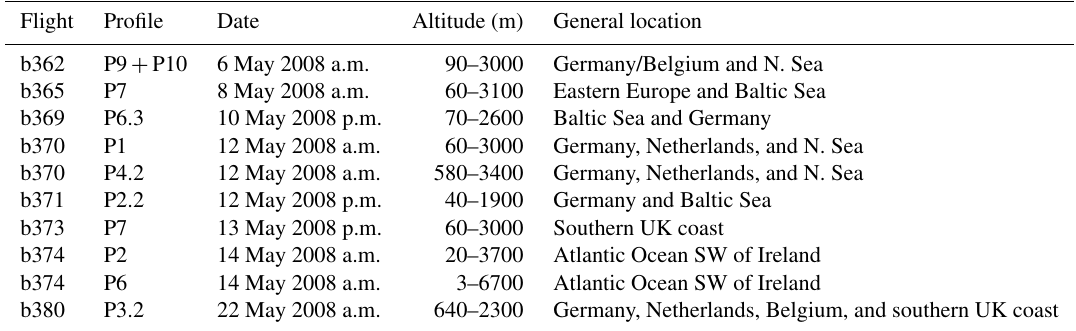
Table 1. Flights and deep vertical profiles selected to calculate the radiative effect of aerosols over Europe during EUCAARI-LONGREX. Deep vertical profiles provide the most complete description of the vertical distribution of the aerosol.